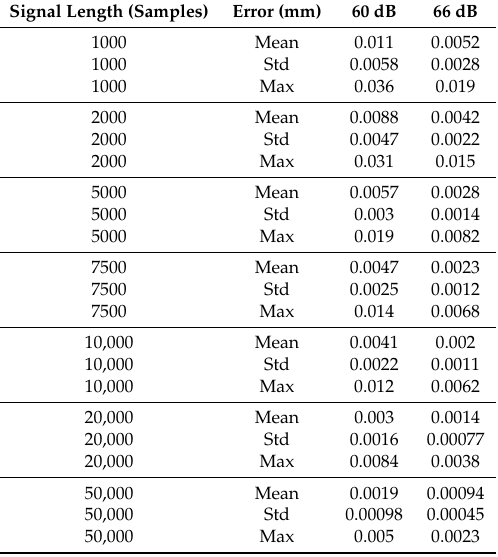
Table 5. Mean values, standard deviation, and maximum values of the mean error of the three emitters in the calculation of the reception point on the PSD surface using FDMA with IQ as a function of SNR and signal size for experimental